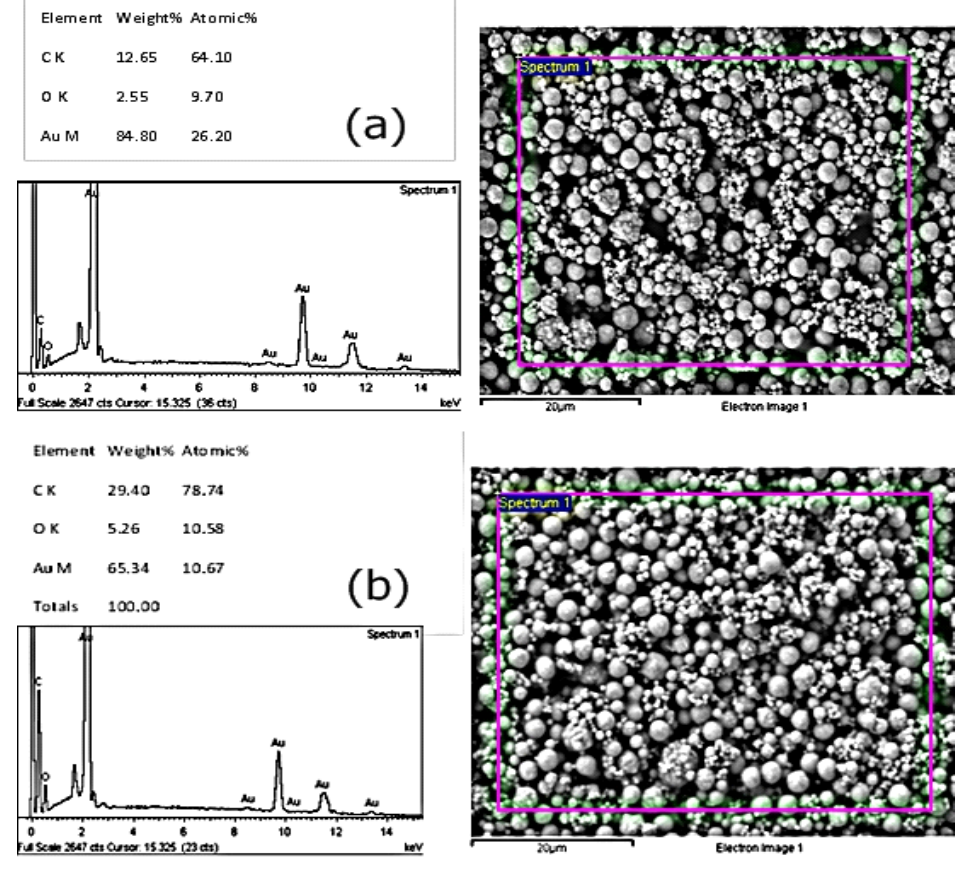
Figure 1. The scanning electron microscope analysis of differently-cured gold inks: ( a ) alternatively-dried sensors and ( b ) infrared-dried